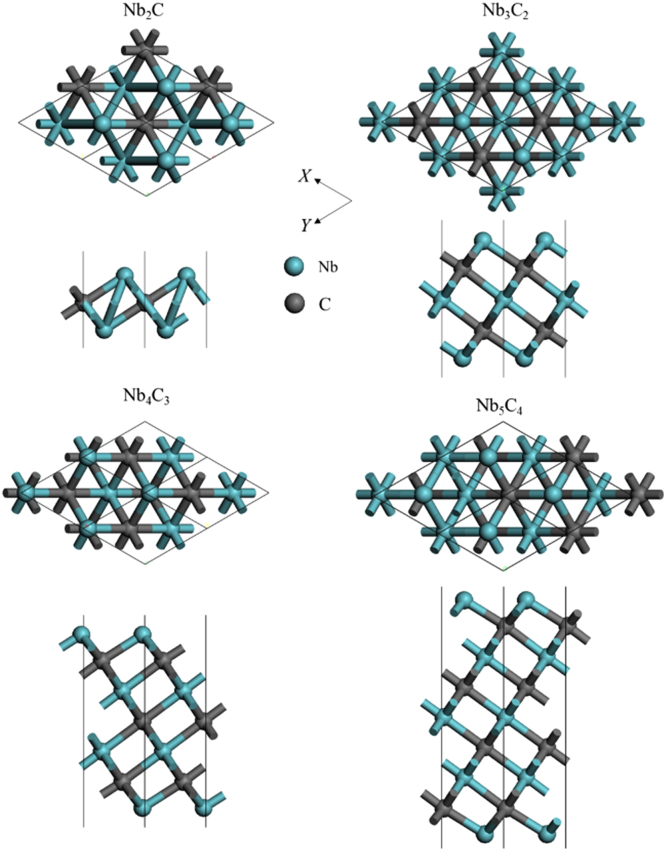
Top views and side views from the X direction of the optimal structures of Nb2C, Nb3C2, Nb4C3 and Nb5C4.